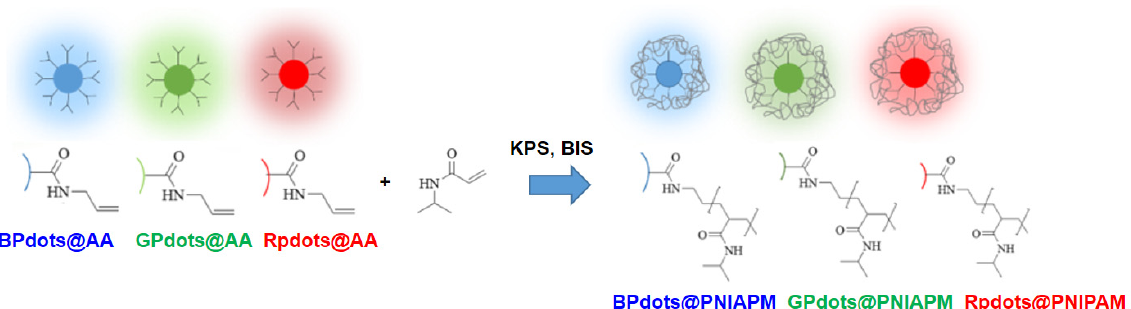
Table 3. DLS results of Pdots@PNIPAM.